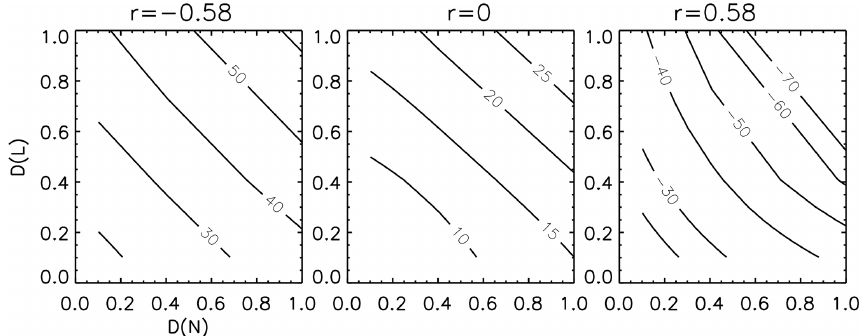
Figure 1. Theoretical calculations of the albedo susceptibility bias (%) for a range of relative dispersions in L and N ( D ( L ) and D ( N ), respectively) for three different correlations ( r ) between L and N . Note the values of large positive and negative biases.